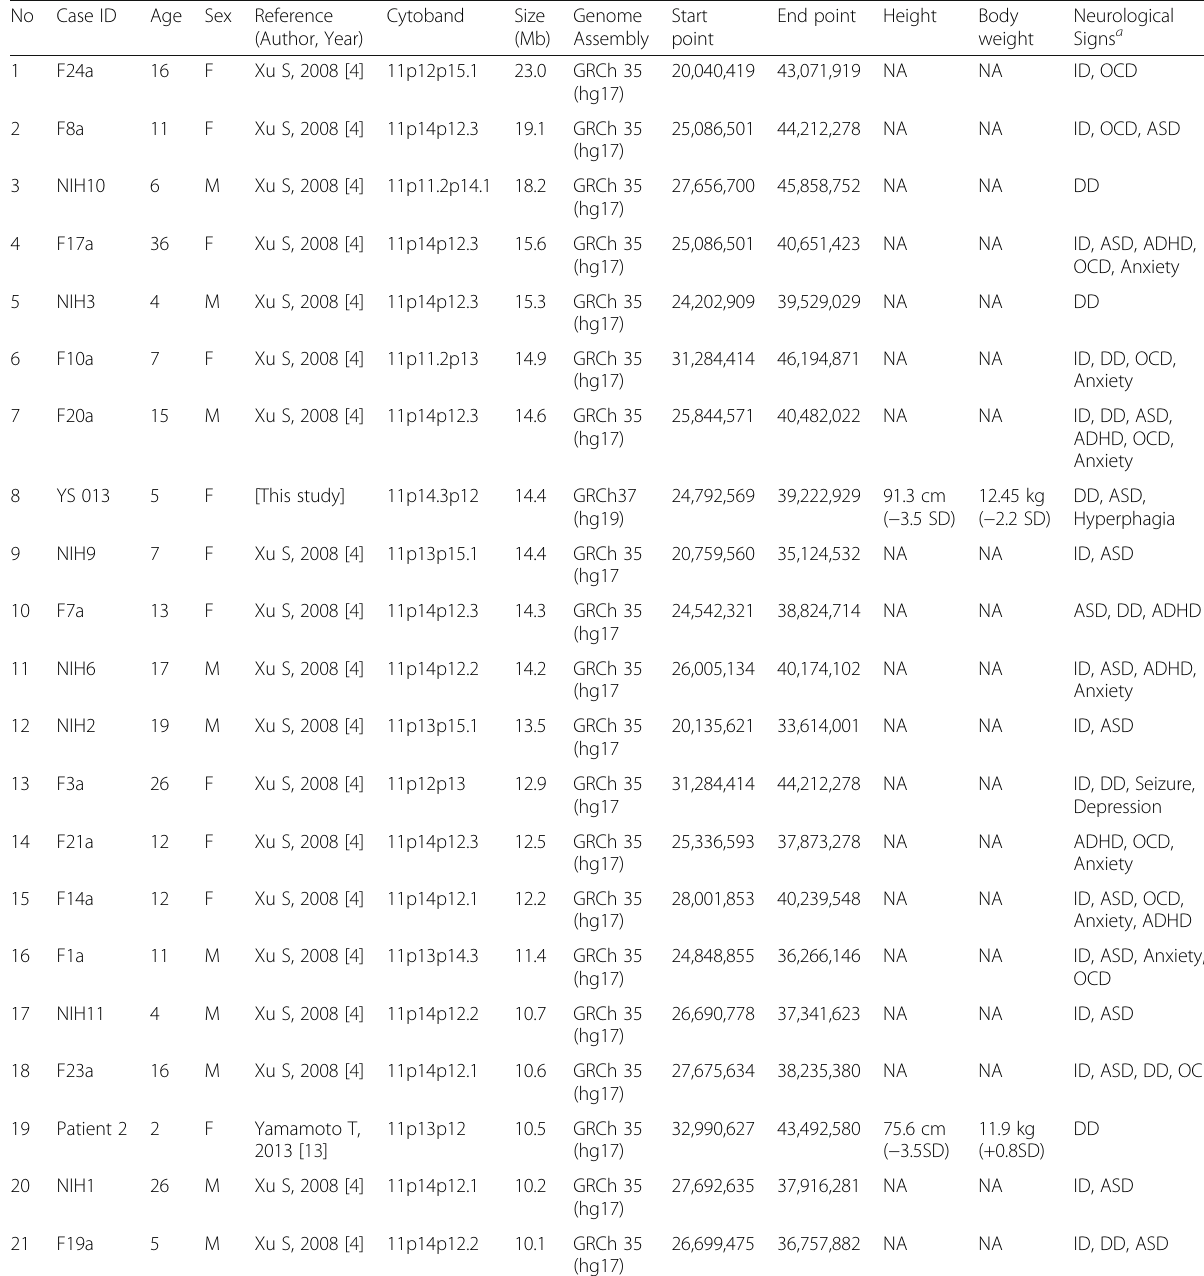
Table 1 Phenotypic spectrum of WAGR syndrome with 10 Mb or larger deletions No Case